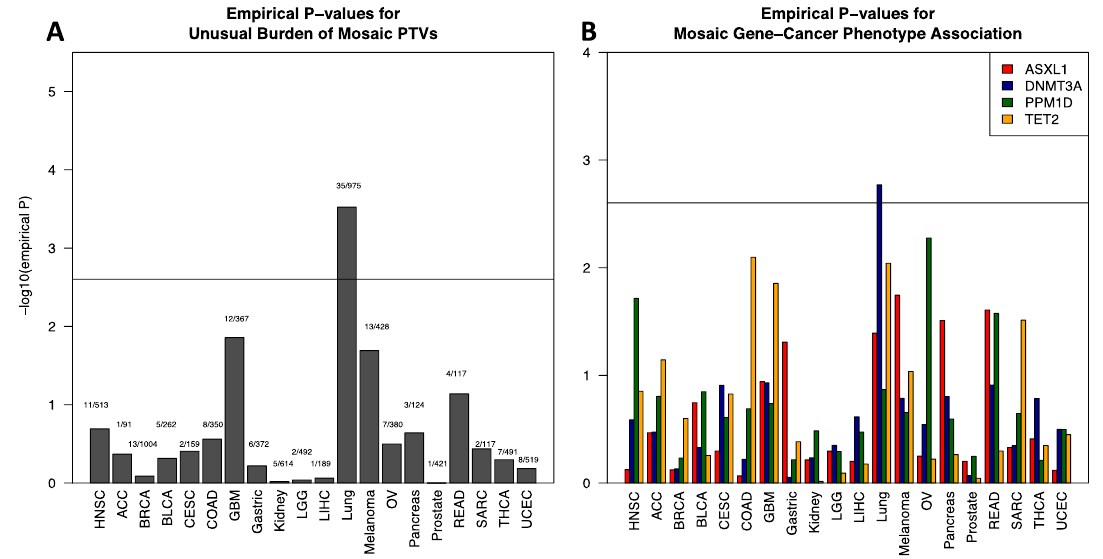
Fig. 2 Solid-tumor cancer phenotypes show gene speci fi city with respect to mosaic PTVs. a Empirical enrichment of the different cancer phenotypes with mosaic PTVs b Per gene signi fi cance of mosaic PTV burden in each cancer phenotype. Experiment-wise signi fi cance level is set with Bonferroni correction for multiple phenotypes tested. Ovarian cancer shows previously reported speci fi c association to PPM1D mosaic